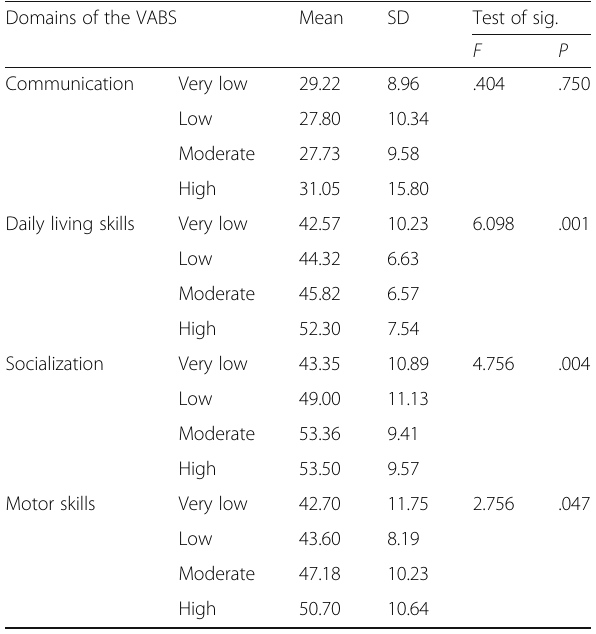
Table 4 Differences of adaptive functioning related to socioeconomic levels of children Domains of the VABS Mean SD Test of sig.